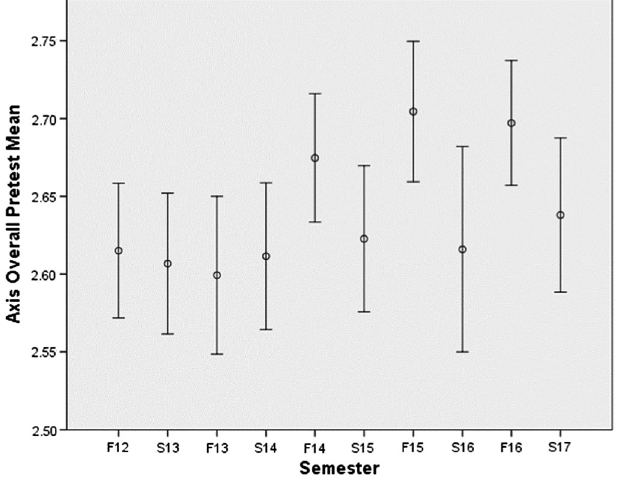
FIG. 1. Error bar plot of average pretest EBAPS score on overall axis by semester.